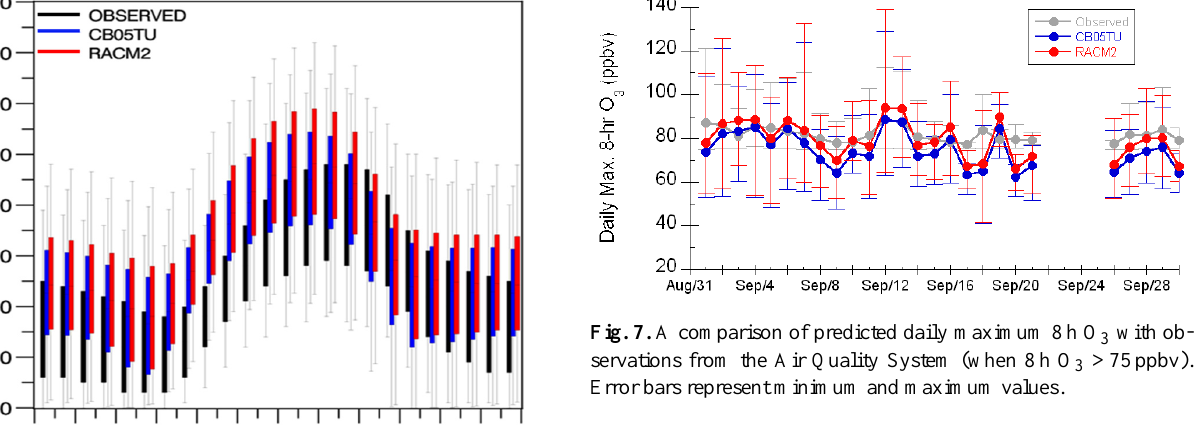
Figure 6: A comparison of diurnal variation of predicted hourly surface O from Air Quality System sites.